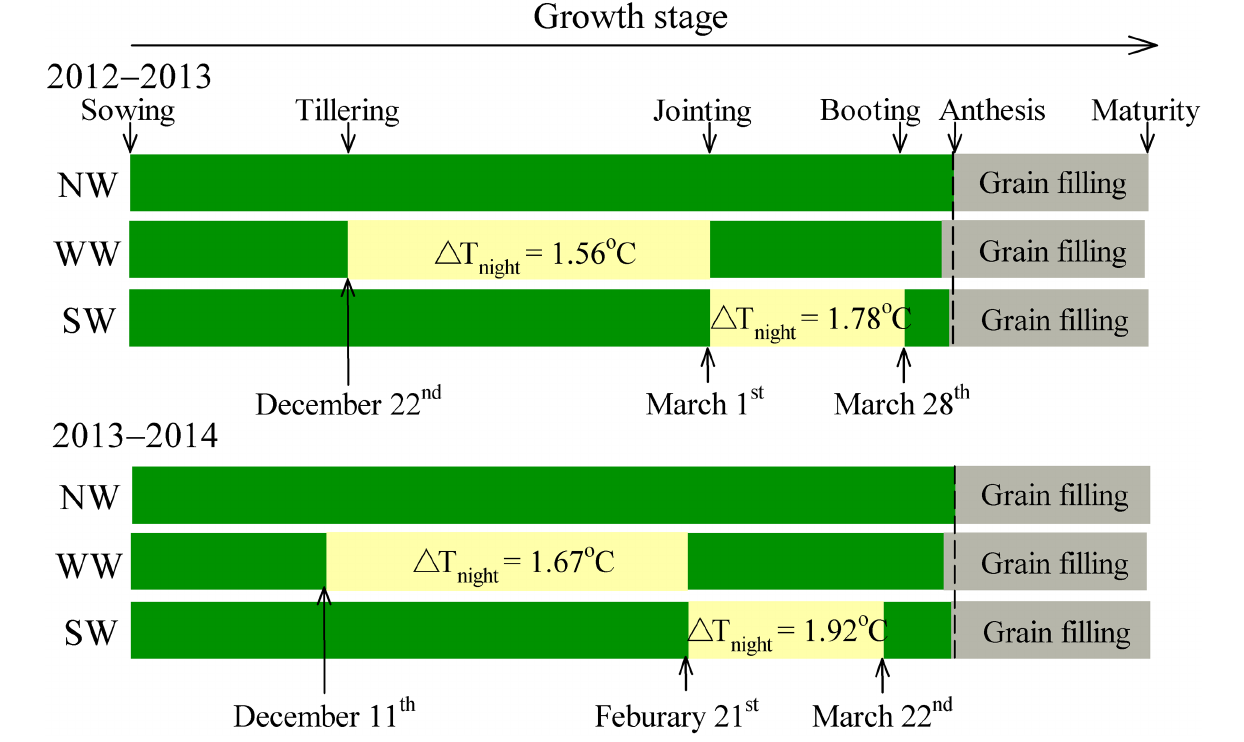
et al. (2009). Superoxide dismutase (EC 1.15.1.1) activity